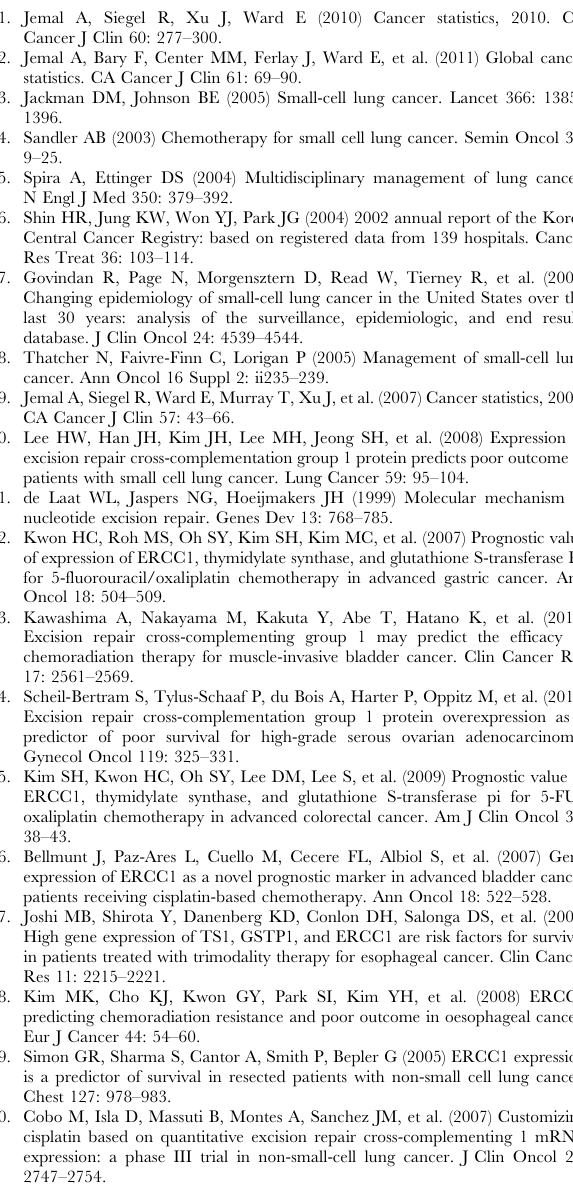
Table S1 Quality assessment of eligible studies with Newcastle- Ottawa